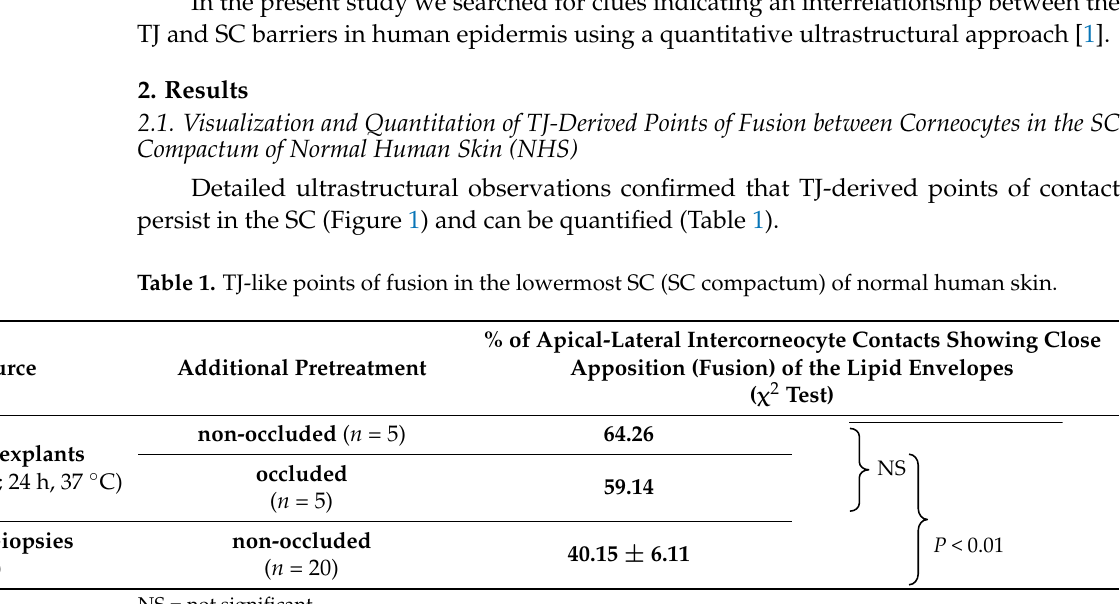
Figure 1. Subdivision of the extracellular space of SC into separate compartments, ( a ) indicated in different colors; ( b ) apical-lateral TJ remnants (arrows) intercalating corneodesmosomes (d) may be quantified; ( c ) an example of “closed” and “open” apical-lateral contacts between the three SC 2 corneocytes. TJ-derived fusions of corneocyte envelopes seal the extracellular space (*). Bar in ( a ) = 1 µm; in ( b , c ) = 200 nm.